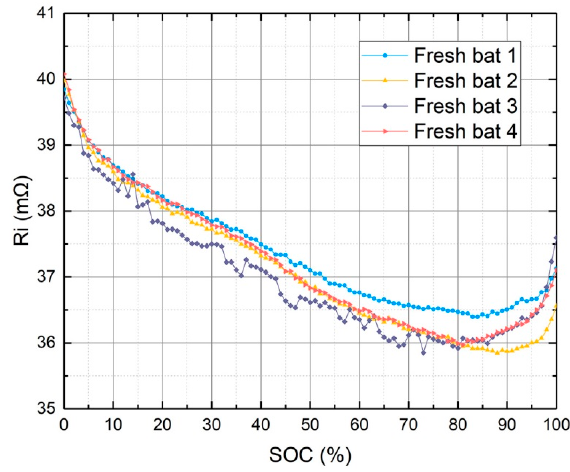
Figure 4 . R i -SOC plot for different batteries.